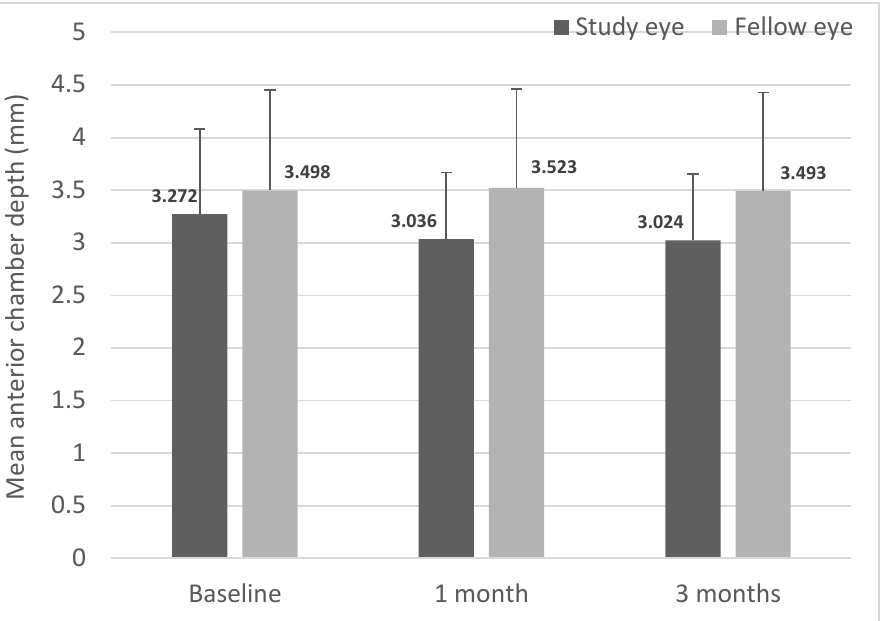
Figure 1. Mean anterior chamber depth (ACD) in study and fellow eyes over 3 months. Anterior chamber depth was measured preoperatively (baseline) and at months 1 and 3 postoperatively (n = 24). Mean anterior chamber depth was significantly reduced in the study eyes compared to the fellow eyes at 1 and 3 months post-SING IMT™ implantation. Data are expressed as mean ± standard deviation. While there was a significant decrease in IOP in the study eye from baseline at the 3-month time point, IOP was not significantly different between eyes at any of the time significant impact on IOP, at least in the short term.